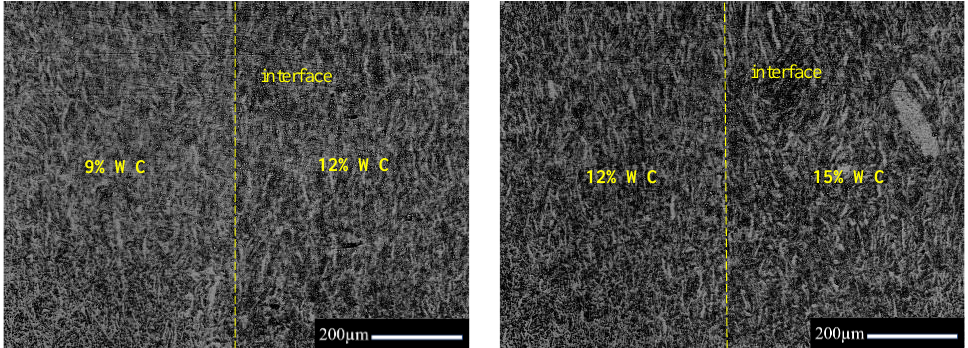
Figure 2. Optical images of Cu/WC P composites with different WC contents.